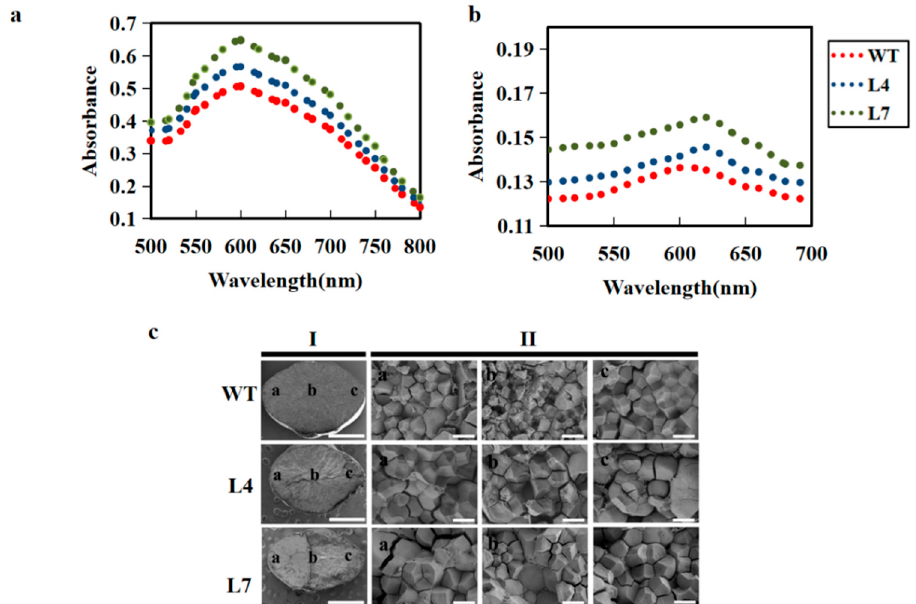
Figure 6. The overexpression of ZmCBM48-1 in rice influenced the starch structure and gelatinization properties. ( a ) Absorbance spectra of the isolated amylose-iodine complexes. BV at 620 nm and λ max represent the ability of amylose to combine with iodine. ( b ) Absorbance spectra of the isolated amylopectin–iodine complexes. BV at 590 nm and λ max represent the ability of amylopectin combined with iodine. ( c ) Scanning electron microscopy (SEM) analysis of the starch structure from mature kernels of the wild type and ZmCBM48-1 transgenic seeds. The ventral area, central area, and dorsal area of the mature endosperm are indicated in a, b, and c ( c ). Scale bars: 1 mm in (I); 10 µ m in (II). BV and maximum λ max can provide indicators for the starch structure and represent the ability of starch binding to iodine [25]; so, we carried out the histological